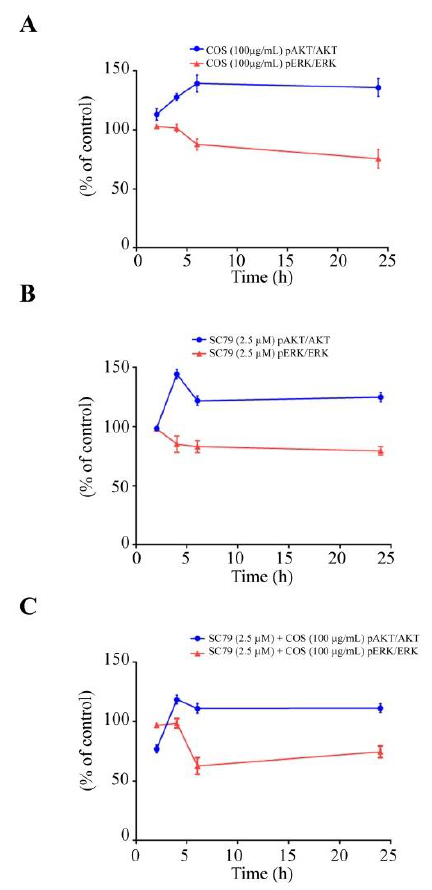
Figure 7. Time course of signaling pathways induced by COS investigated using SC79. ( A ) Effect of COS on p-AKT/AKT ratio and p-ERK/ERK ratio. ( B ) Effect of SC79 on p-AKT/AKT ratio and p-ERK/ERK ratio. ( C ) Effect of COS with SC79 pre-treatment on p-AKT/AKT ratio and p-ERK/ERK ratio. Data are expressed as % of control (vehicle-treated group) ± S.D. ( n = 3).